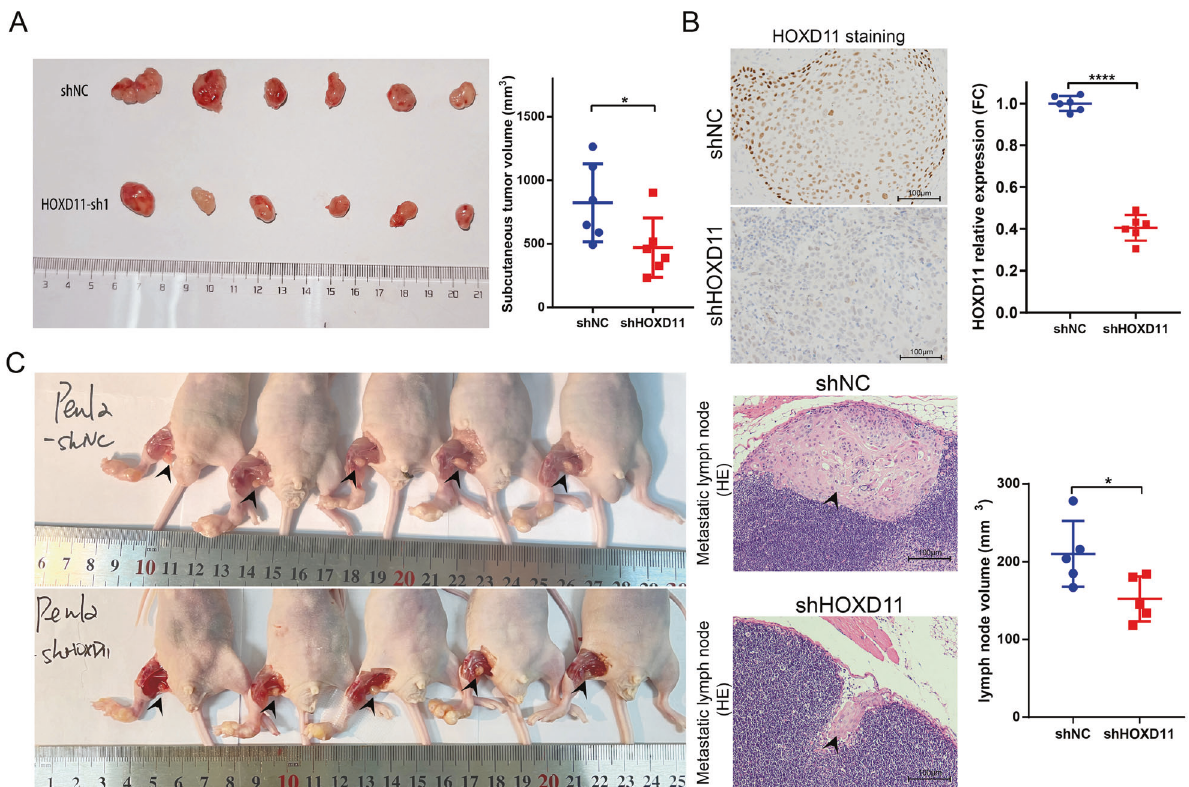
Fig. 4 Knockdown of HOXD11 inhibited tumor growth and popliteal lymph node metastasis in vivo. Penl2 HOXD11-sh1 cells were injected subcutaneously to establish xenograft tumor model in BALB/c nude mice ( n = 6) for three weeks. A Knockdown of HOXD11 inhibited tumor growth in vivo. B IHC was performed to detect the expression of HOXD11 in two groups. The mRNA expression of HOXD11 was knockdown in subcutaneous tumors of the shHOXD11 group. C The effect of HOXD11 on lymph nodes metastasis was explored by an inguinal and popliteal lymph node metastasis model ( n = 6). Knockdown of HOXD11 inhibited the volume of popliteal lymph node, and HE staining demonstrated the reduction of lymph node metastasis. * p < 0.05. NC, negative control; HE, hematoxylin-eosin; IHC,